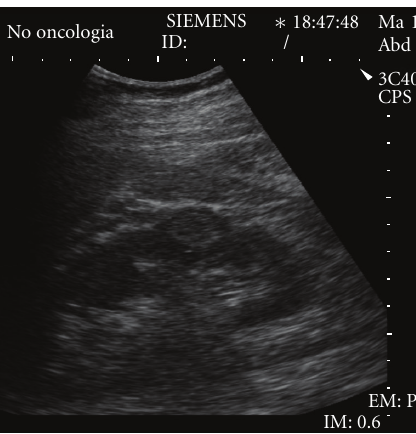
Figure 2: A cyst with nodular thickening of the wall and internal septa.